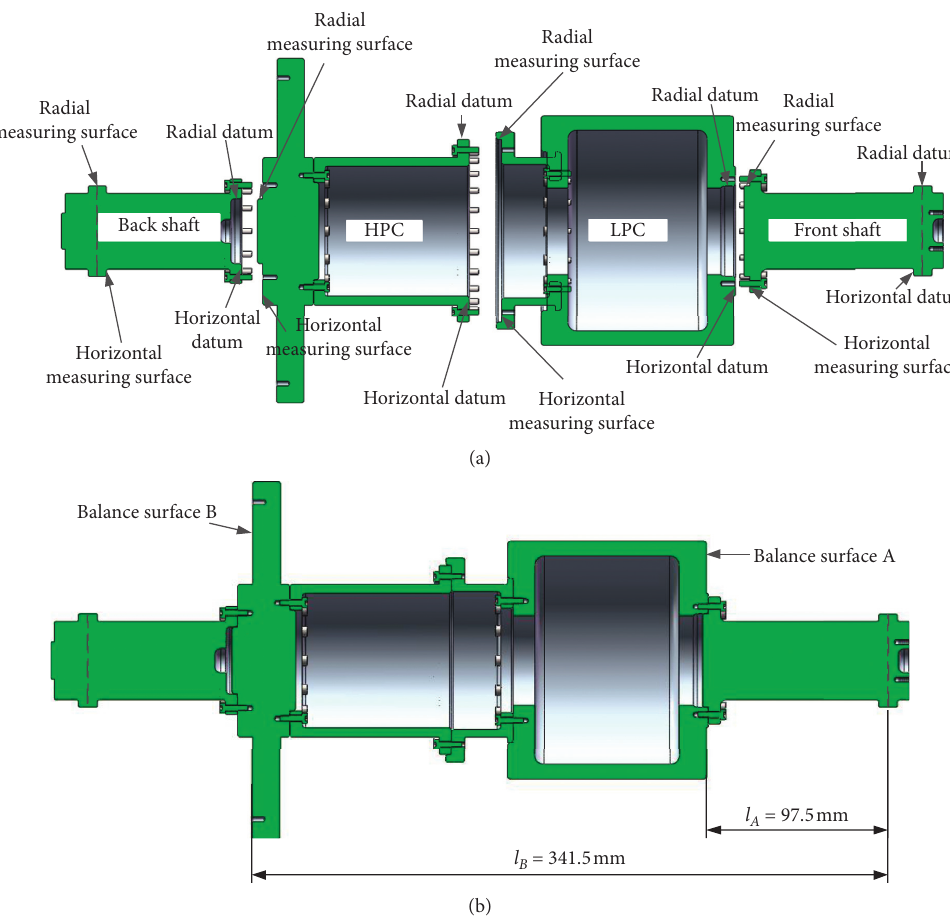
Figure 10: The section view of the 4-stage rotor. (a) Exploded view. (b) Assembled view.